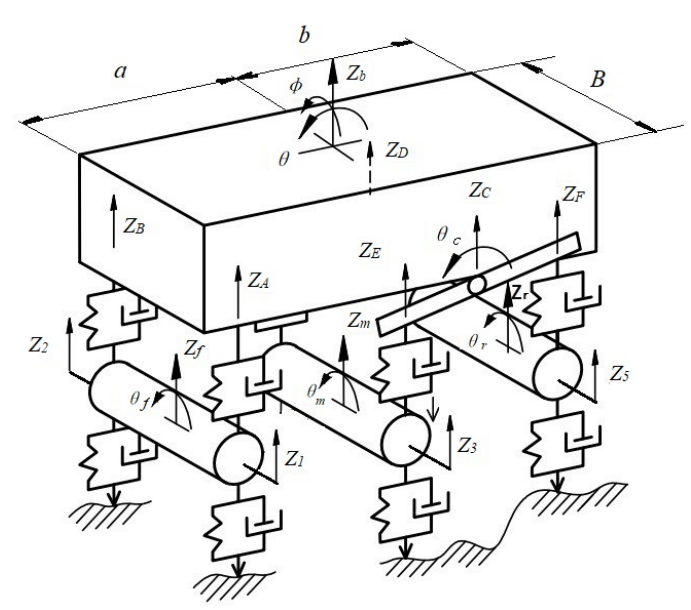
Figure 6. Eleven-DOFs dynamic model of a dump truck.